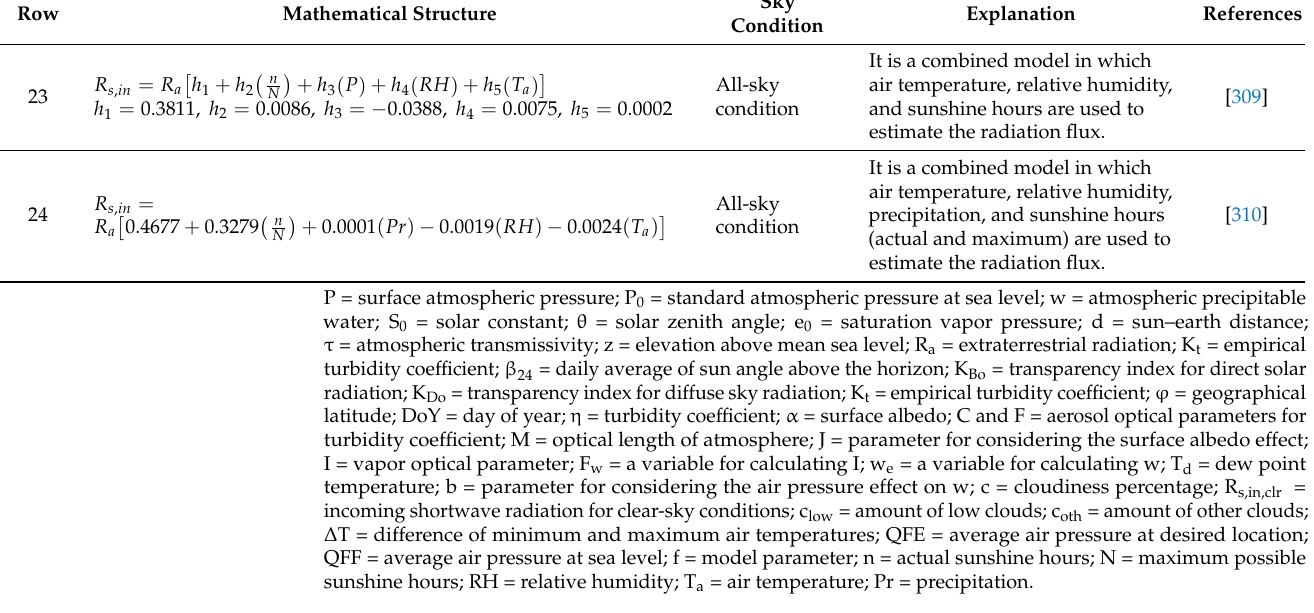
Table A2. Estimation models of R l , in under clear- and all-sky